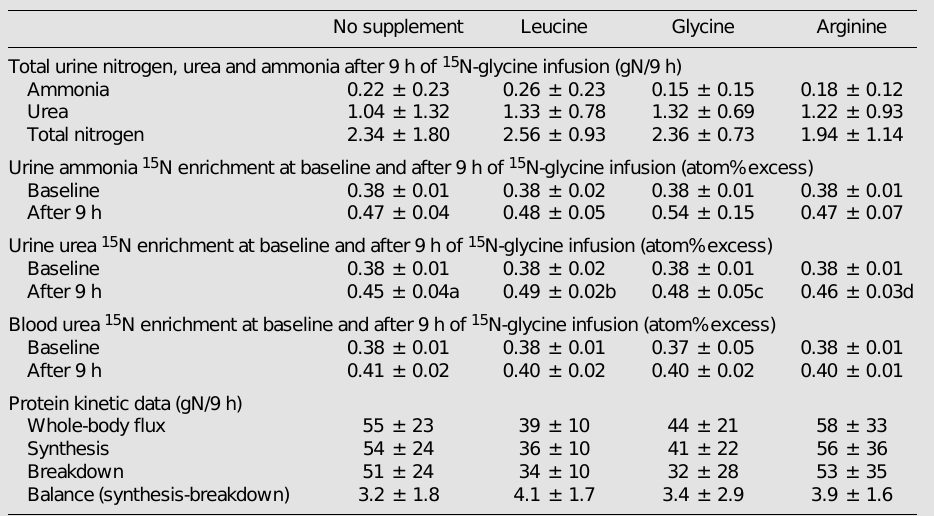
Table 2. Kinetic data after a single dose of 15 N-glycine during the periods of no supplementation and supplementation with leucine, glycine or arginine (in random order). No supplement Leucine Glycine Arginine Total urine nitrogen, urea and ammonia after 9 h of 15 N-glycine infusion (gN/9 h) Ammonia